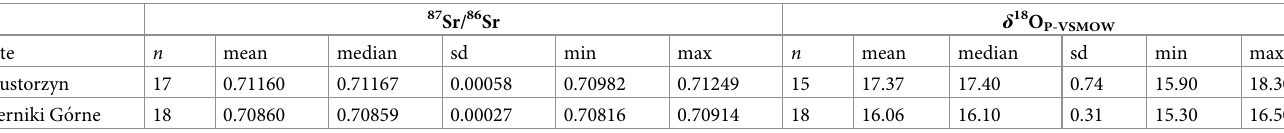
Table 2. Descriptive statistics of isotopic data for humans from Gustorzyn and Ż erniki